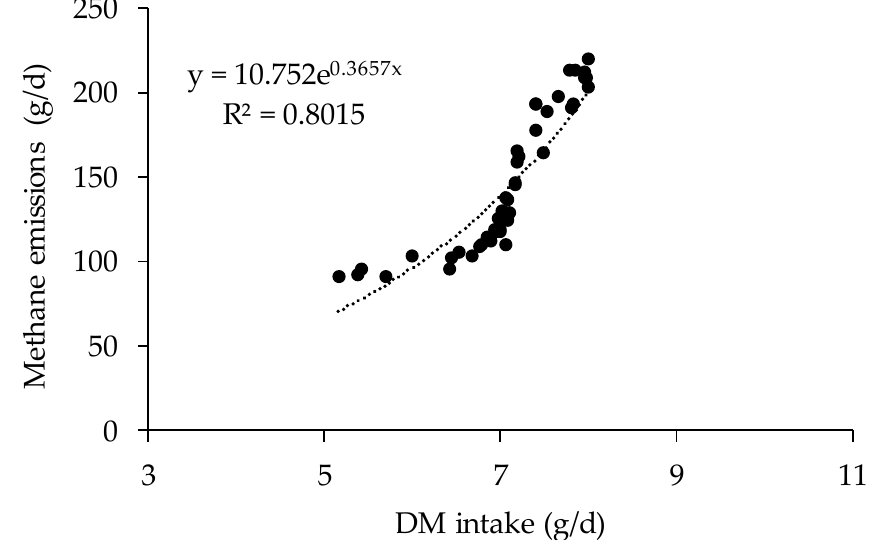
Figure 2. Non-linear relationship between dry matter intake and enteric methane emissions of Holstein heifers.